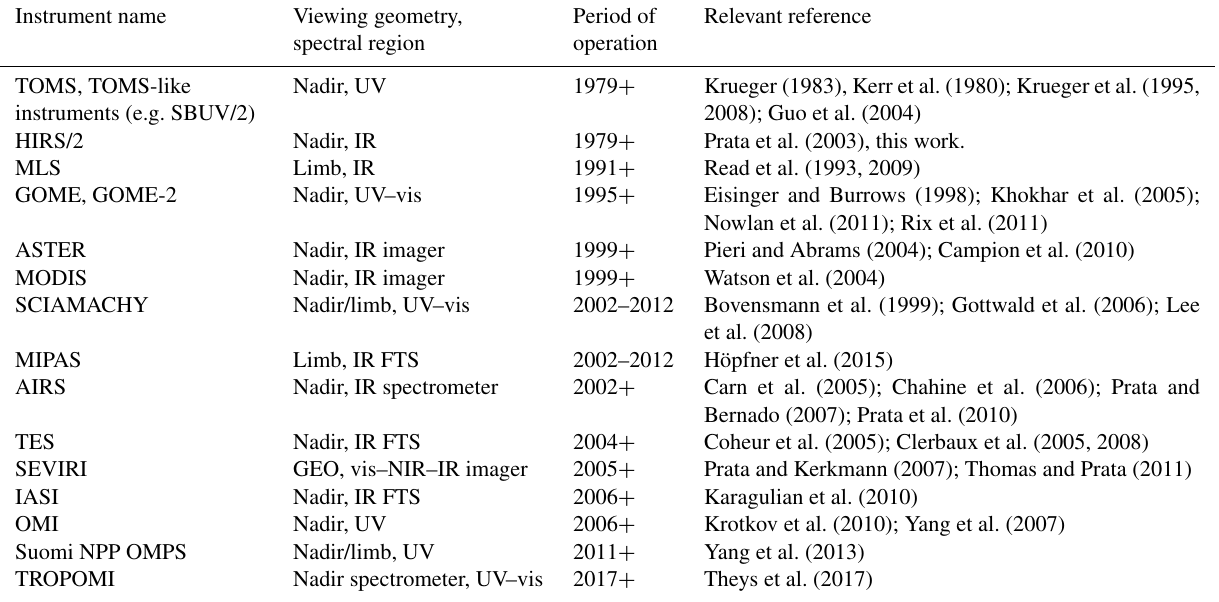
Table 1. Instruments (many of which were flown aboard several different platforms which are not listed) that have been used to measure volcanic SO 2 in the